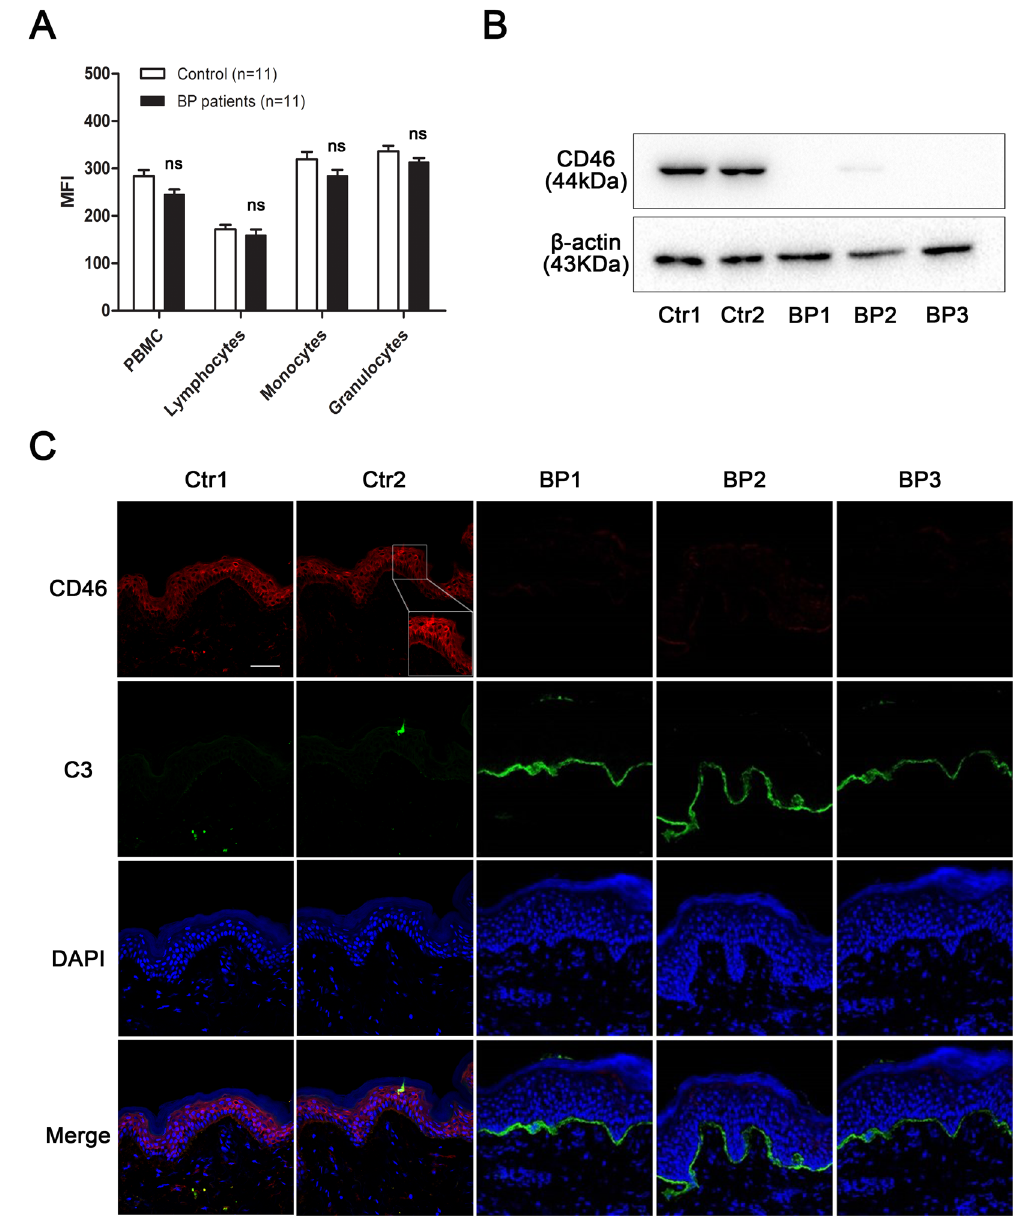
Figure 2. Down-regulation of mCD46 in BP patients. ( A ) Flow cytometry analysis of mCD46 expression in peripheral blood. Results represent the mean ± SEM from eleven independent experiments. NS represent no significant difference between control and BP patients. ( B ) Protein expression of CD46 in skin sections was examined by western blot. ( C ) IF staining was performed on normal skin sections and lesions from BP patients to measure CD46 expression in the epidermal keratinocytes and C3 deposition in the DEJ. DAPI staining of nuclei is shown in blue. Scale bar, 100